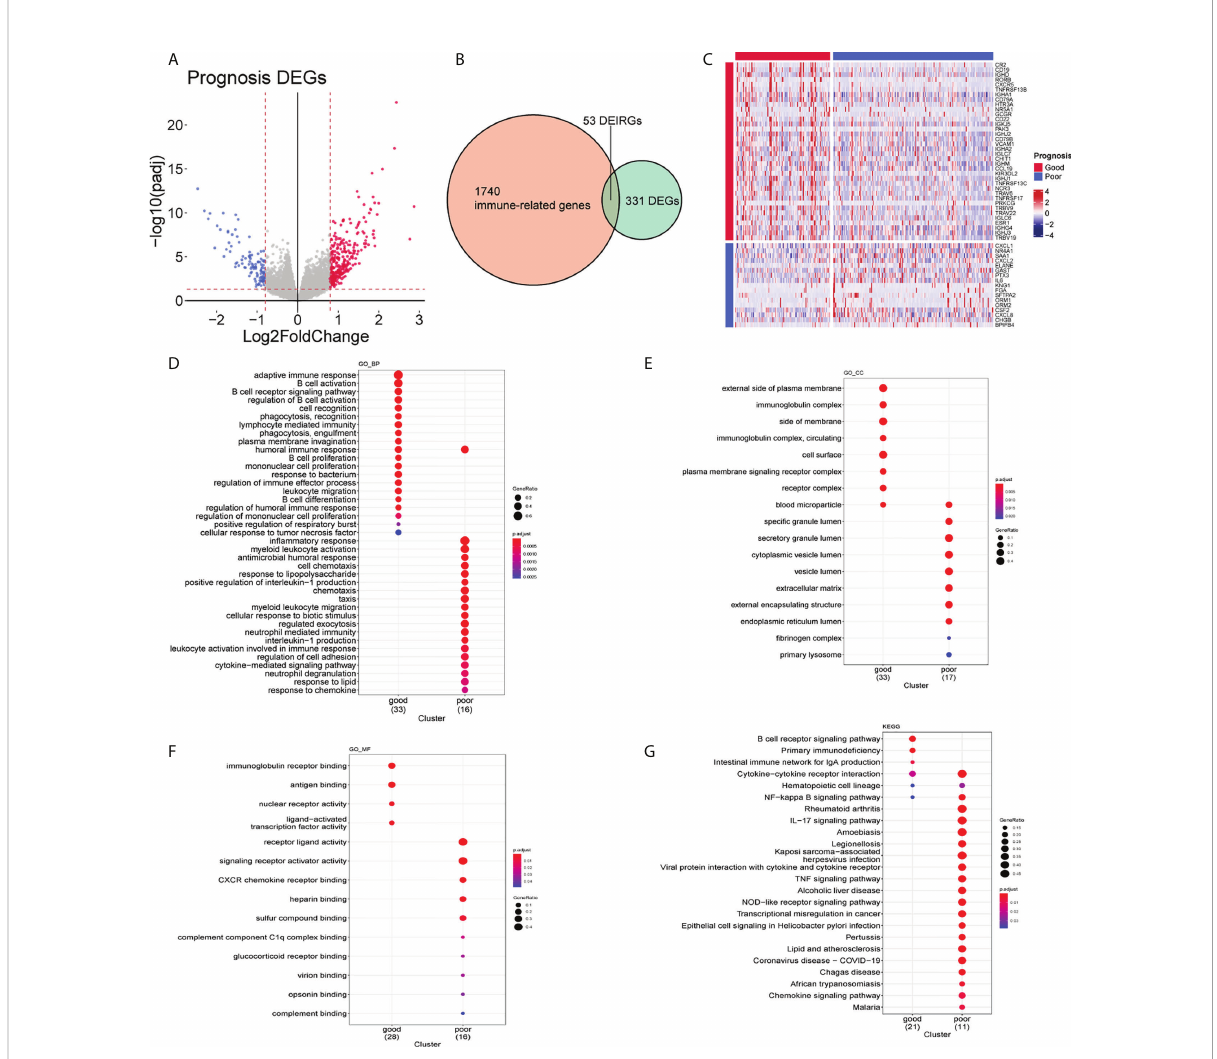
FIGURE 4 Molecular characteristics of good- and poor-prognosis subgroups. (A) Differentially expressed genes (DEGs) of good- and poor-prognosis groups in the The Cancer Genome Atlas (TCGA) data set. (B) DEIRGs identi fi ed by the intersection of DEGs and IRGs. (C) Expression levels of 53 DEIRGs of HNSCC tissues in good- and poor-prognosis groups. (D – F) Gene Ontology (GO) enrichment plots of good- and poor-prognosis groups on the biological process (D) , cellular component (E) , and molecular function (F) . (G) Kyoto Encyclopedia of Genes and Genomes (KEGG)-pathway enrichment plot of good- and poor-prognosis